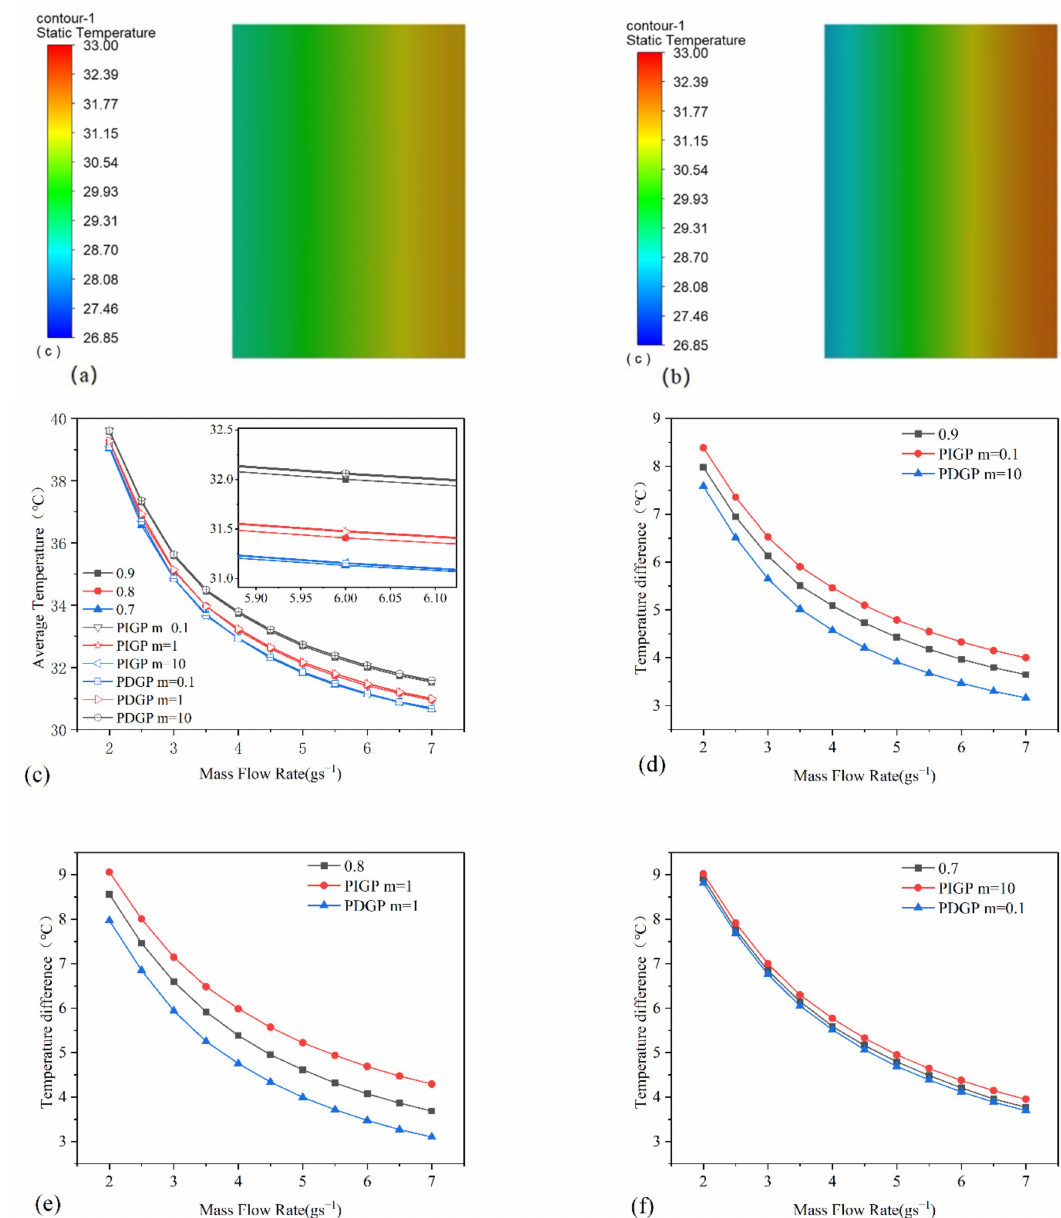
Figure 17. With AFHS with gradient porosity designed in the X -axis direction: ( a ) temperature distributions of battery with AFHS of PDGP m = 1; ( b ) temperature distributions of battery with AFHS of PIGP m = 1; ( c ) average surface temperature; ( d ) temperature difference of equivalent porosity = 0.9, ( e ) temperature difference of equivalent porosity = 0.8, and ( f ) temperature difference of equivalent porosity =